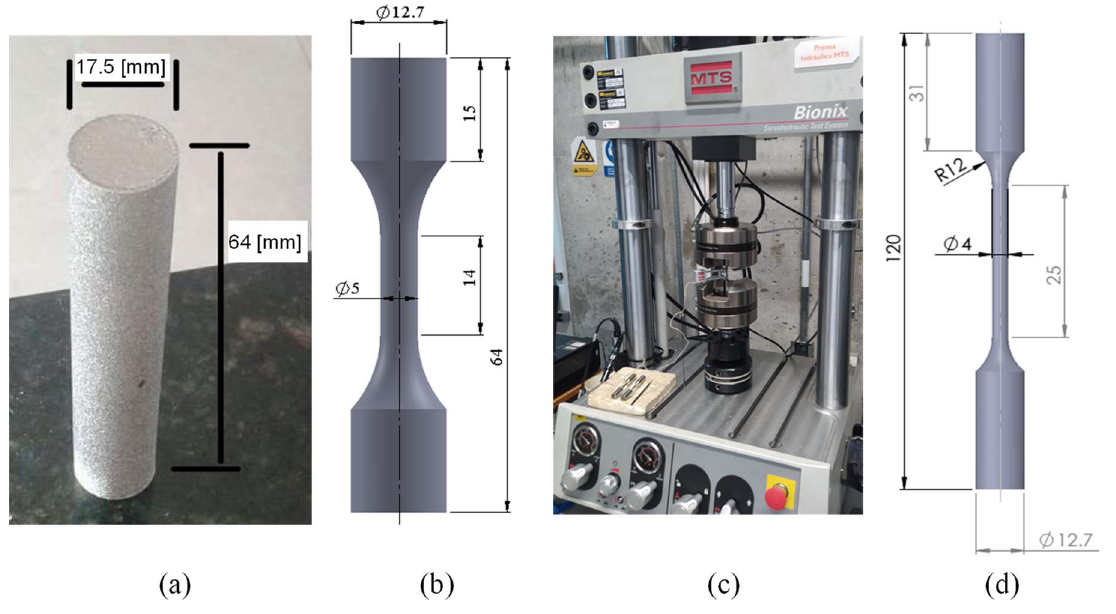
Figure 3. Test specimens: ( a ) as printed by EBM; ( b ) machined dimensions (mm) for fatigue tests; ( c ) testing of a specimen with an extensometer; ( d ) machined dimensions (mm) for static tensile tests.